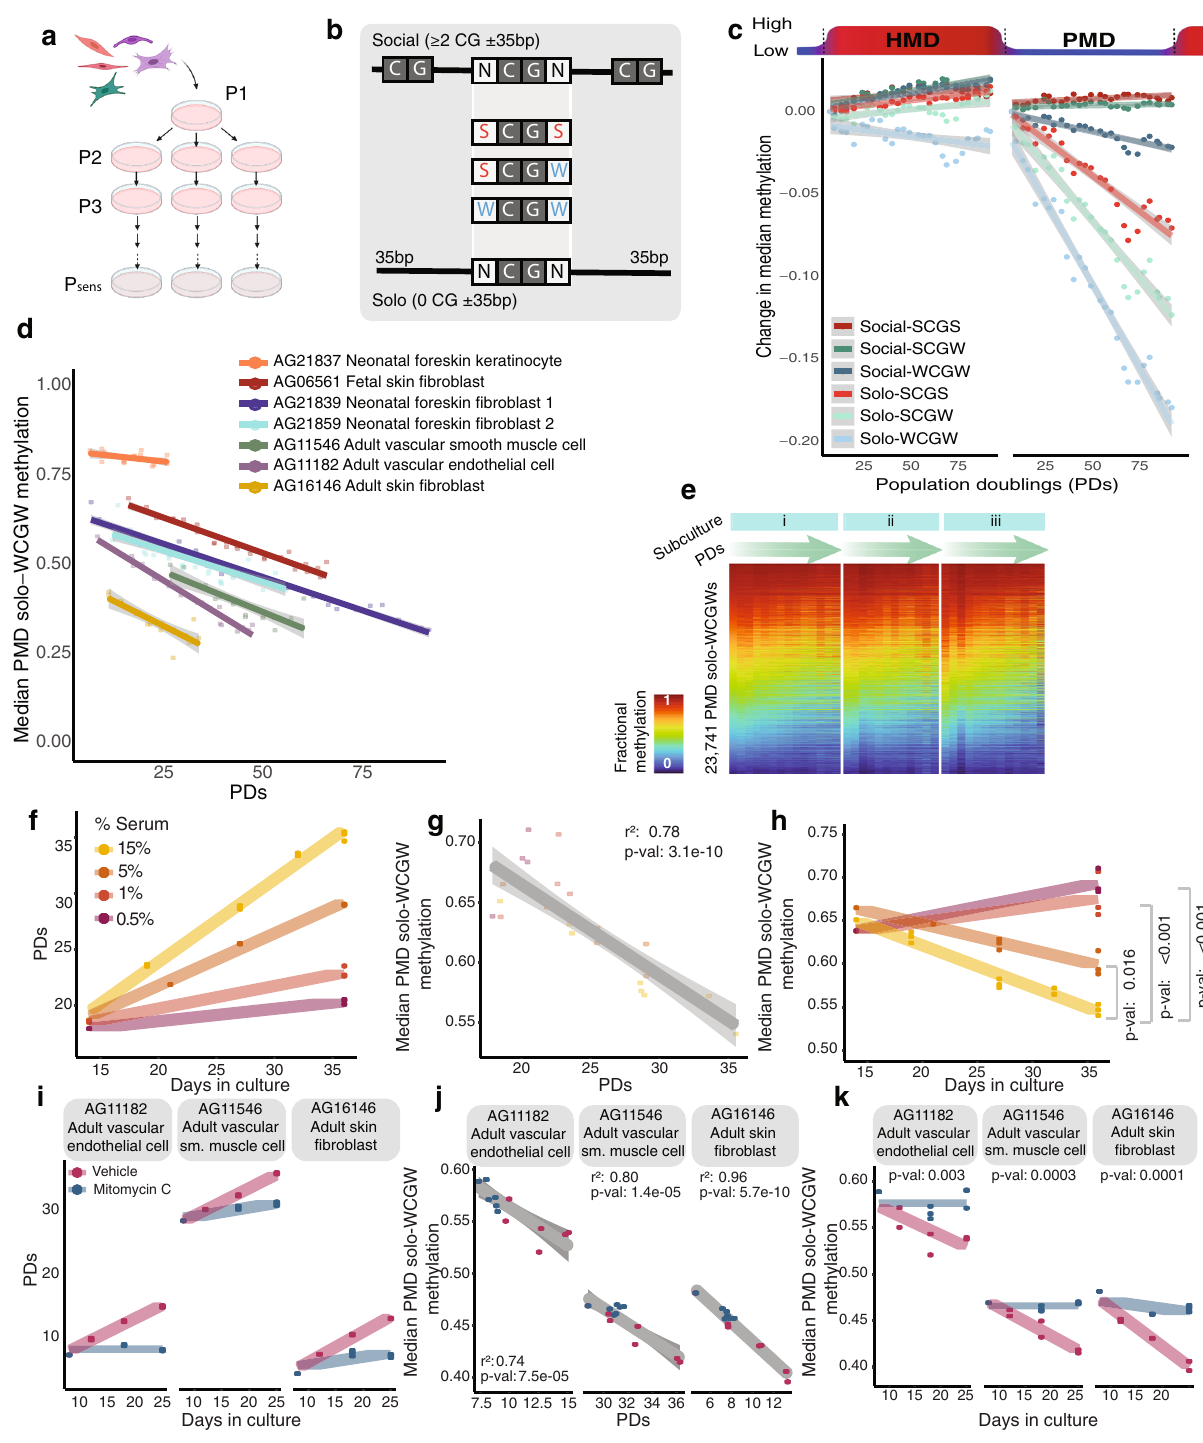
Fig. 1 | Methylation loss at PMD solo-WCGWs is driven by proliferation- associated DNA replication. a Schematic illustration of primary cells cultured through replicative senescence. b Illustration of immediate ( ≤ 35bp) CpG contexts investigated in thisstudy. c Fractionalmethylationchange per population doubling (PD) for neonatal foreskin fi broblast AG21839 at select CpG contexts, within and outside of common partially methylated domain (PMD) boundaries. HMD: highly methylated domains. CpGs within CGIs were excluded. d Median fractional methylation of multiple primary cells derived from unique donors and tissues ( n =7) plotted against PDs achieved during this study. e DNA methylation heatmap of PMD solo-WCGWs during primary cell culture of neonatal foreskin fi broblast AG21859. Heatmap is separated by parallel subculture, with samples ordered from